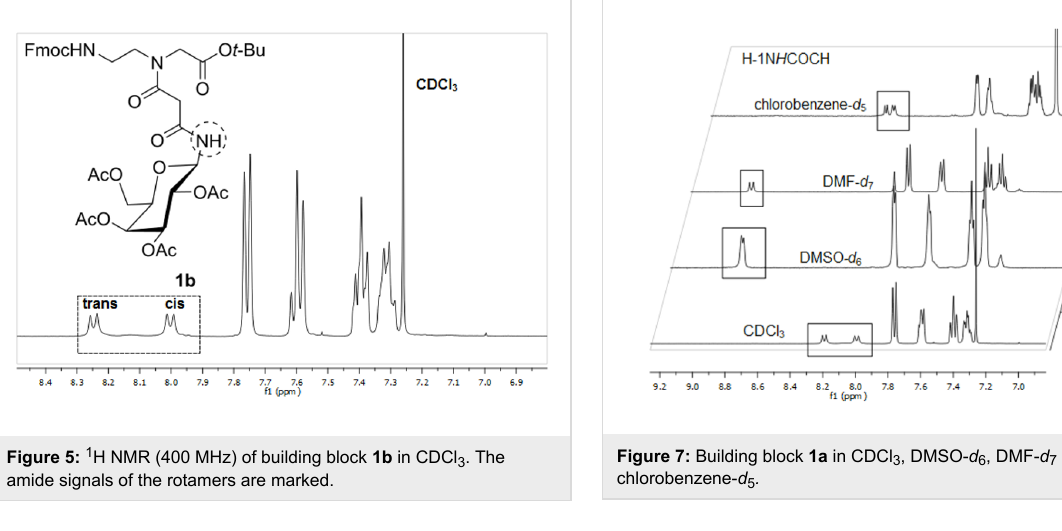
Figure 7: Building block 1a in CDCl 3 , DMSO- d 6 , DMF- d 7 and chlorobenzene- d 5 .